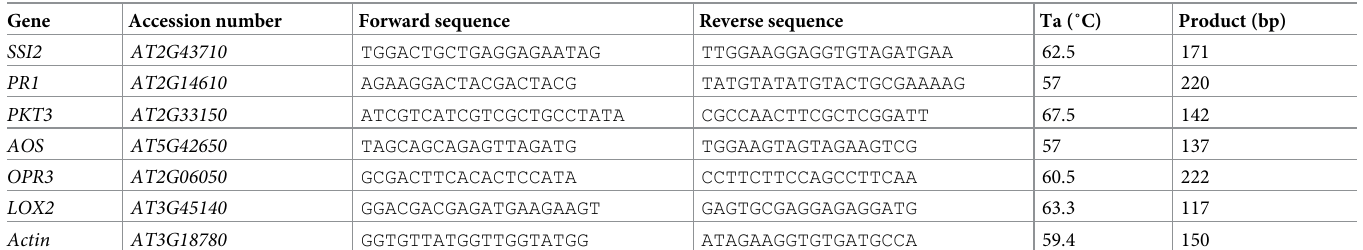
Table 1. Primer sequences used in the